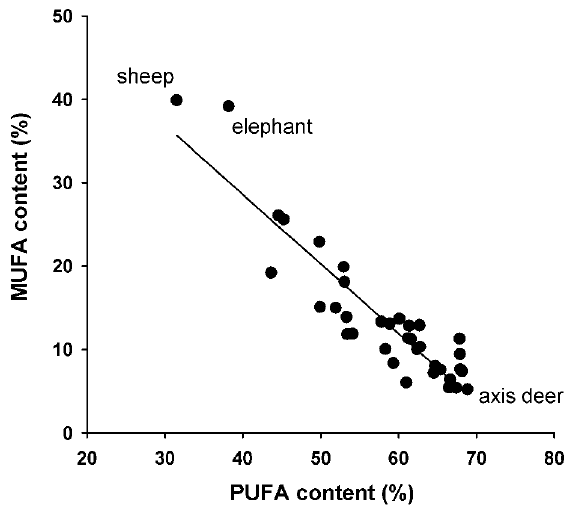
actual velocities, the regression line in Fig. 1B indicates that predicted MRS increased from 13.0 to 49.2 km h 2 1 as n-6 PUFA content increased from 12.2 to 61.5%. This corresponds to a speed gain of 0.734 km h 2 1 for each percent increase in the proportion of n-6 PUFAs. PLoS ONE |